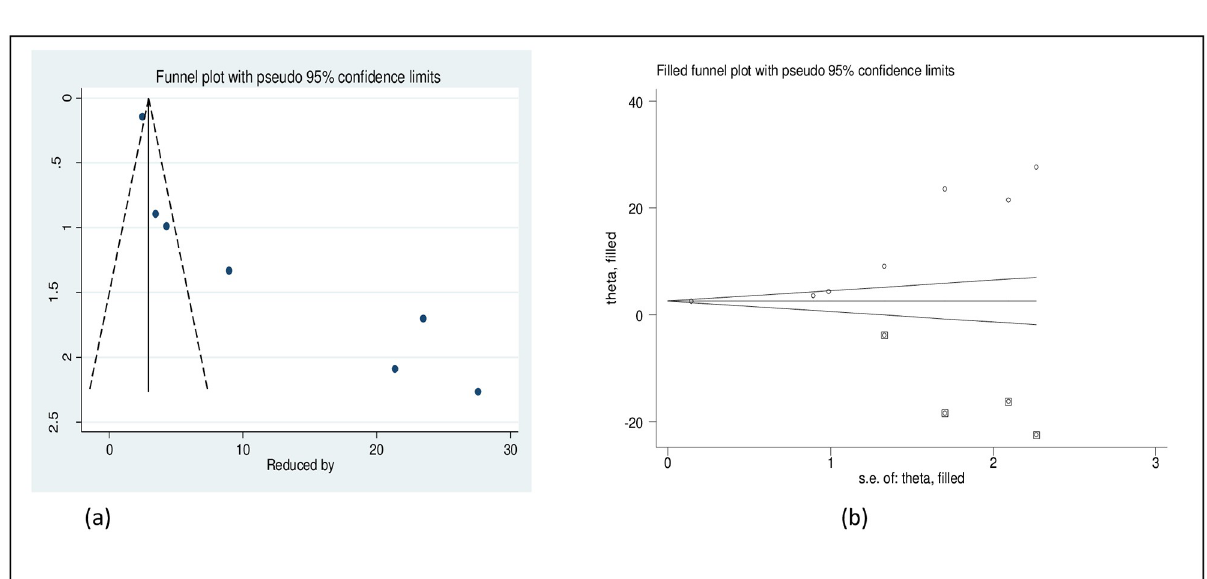
Fig 10. Original funnel plot (a) and filled funnel plot (b) of all included studies.